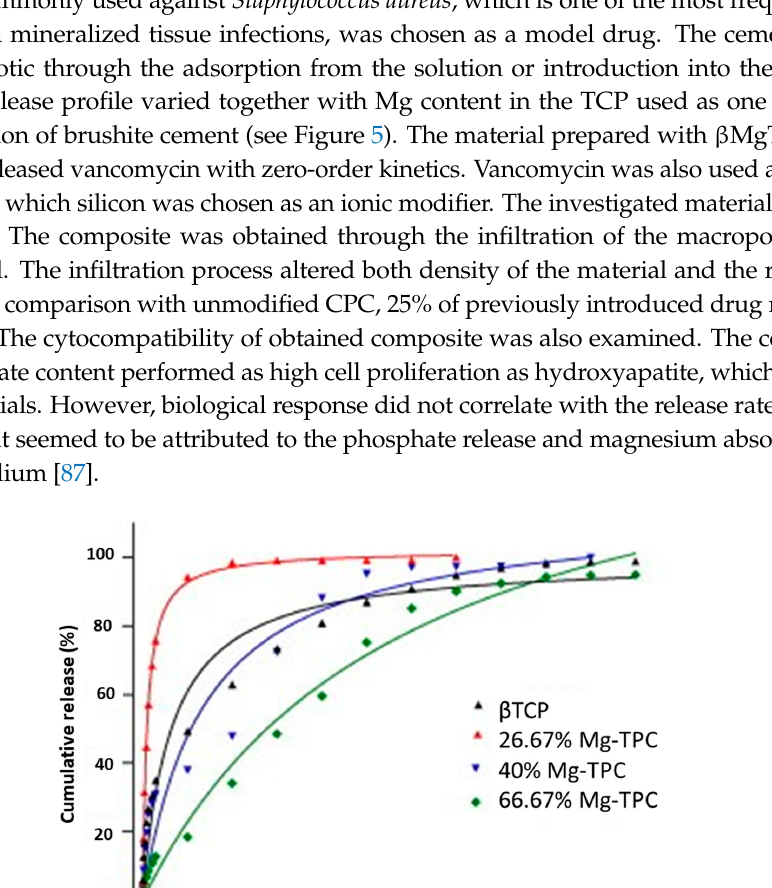
Figure 5. Release of vancomycin from different CPCs. Reprinted from [85] with permission from Elsevier.